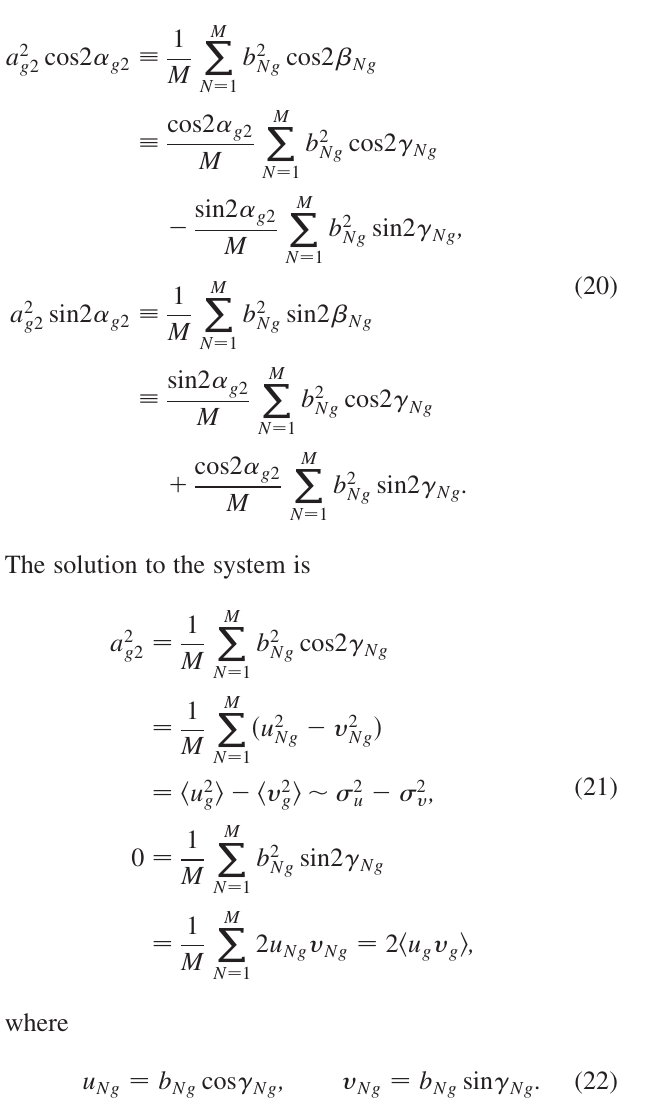
Þ are (7.16, 1.49), (7.43, 2.48), and (7.96, ; (cid:11) u v